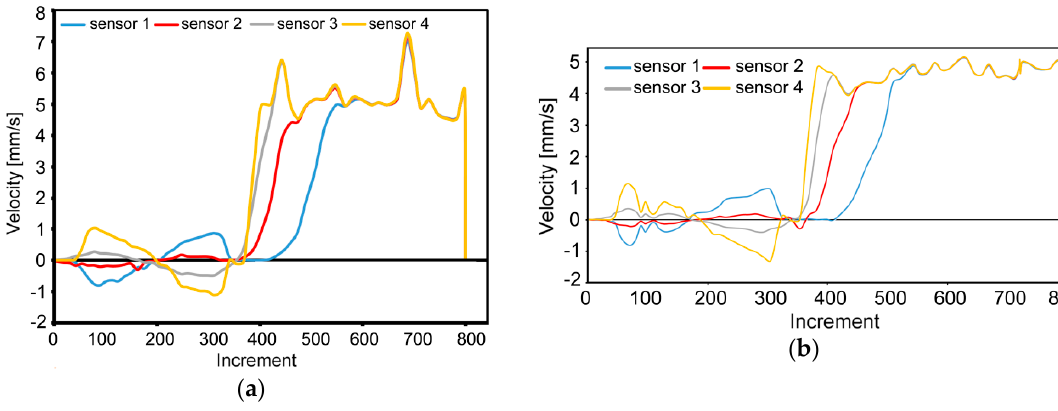
Figure 7. Development of plastic flow velocity during: first pass ( a ); second pass ( b ).